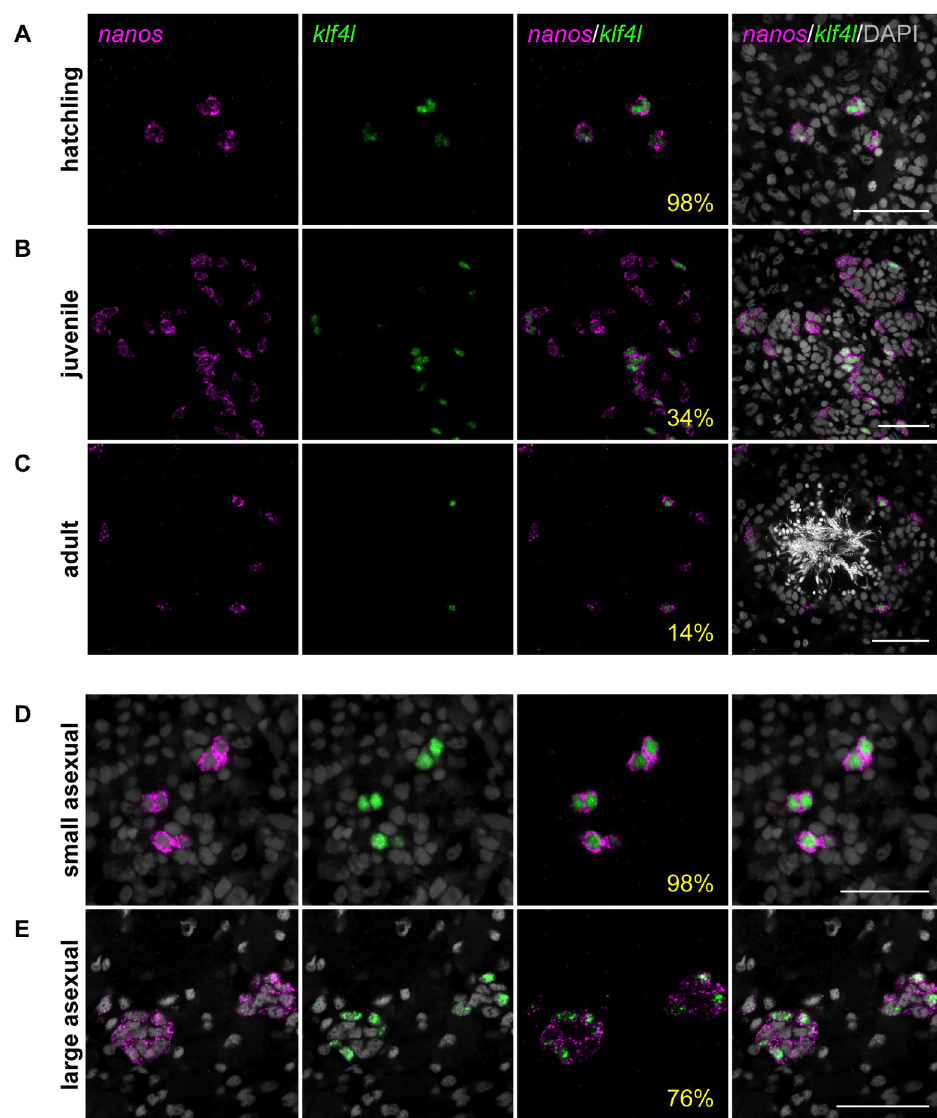
Fig 2. klf4l expression becomes restricted to a subset of nanos + male germ cells during sexual planarian maturation and asexual planarian growth. ( A–C ) Confocal sections showing dFISH of klf4l (green) and nanos (magenta) in hatchling testis primordia ( A ), juvenile testes ( B ), and a sexually mature adult testis ( C ). klf4l is expressed in most nanos + male PGCs in hatchlings and becomes progressively restricted to a subpopulation of nanos + germ cells as planarians sexually mature. ( D , E ) Confocal sections showing dFISH of klf4l (green) and nanos (magenta) in testis primordia in small ( D ) and large ( E ) asexual planarians. klf4l is coexpressed in almost all nanos + male germ cells in small asexuals and is restricted to a subset of nanos + male germ cells in large asexuals. ( A–E ) Percentages reflect nanos + cells that are also klf4l + . Nuclei are counterstained with DAPI (gray). Scale bars, 50 μ m. Underlying data can be found in S1 Data. dFISH, double FISH; klf4l , klf4-like ; PGC, primordial germ